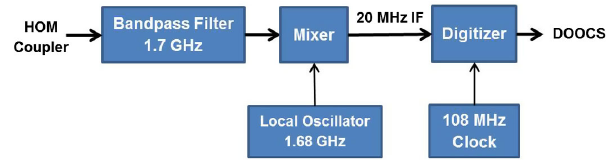
FIG. 6. Block diagram of HOM electronics